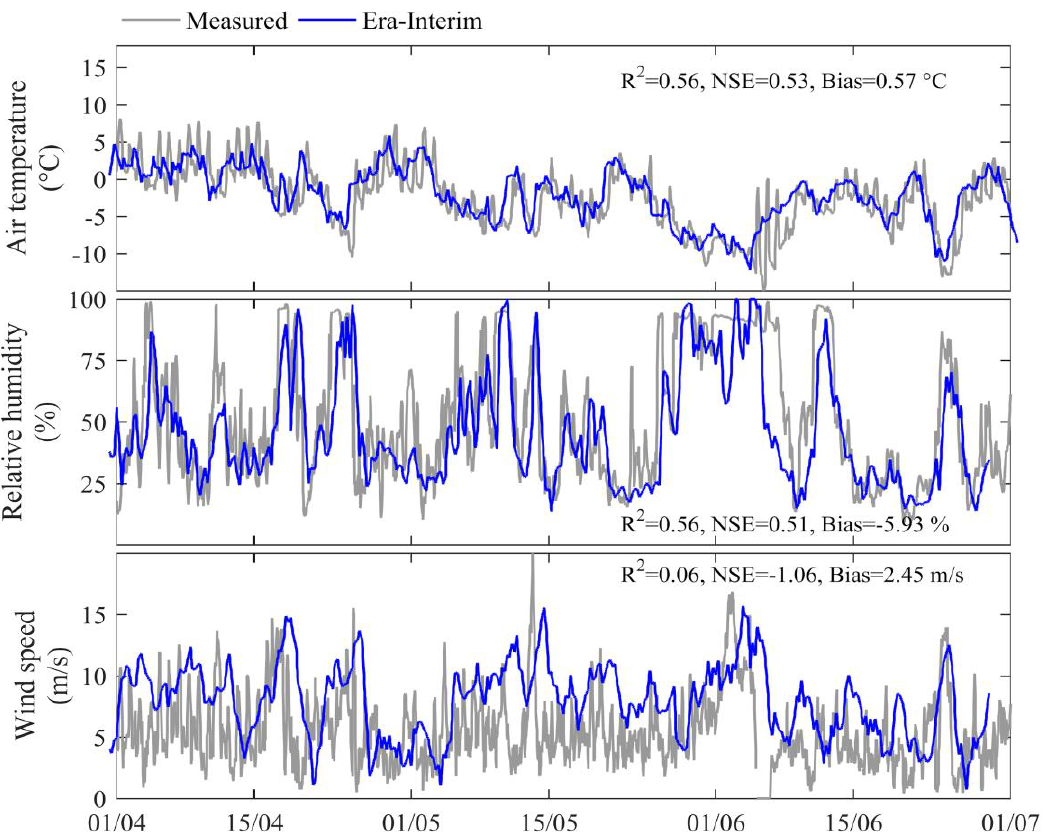
Figure 6. Comparison between measured (gray line) and reanalysis ERA-Interim (blue line) hourly meteorological data at La Ollita station during water year 2016.